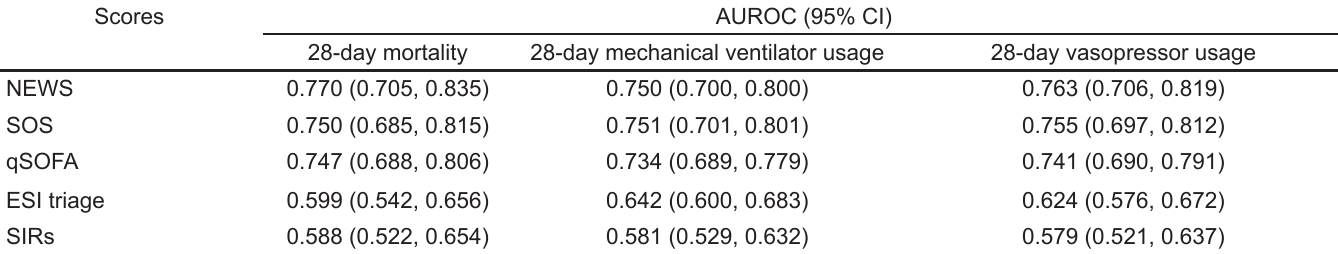
Table 2. The area under the receiver operating characteristic curve with 95% confidence interval of predictive scores for predicting 28- day mortality, 28-day mechanical ventilator used, and 28-day vasopressor used.